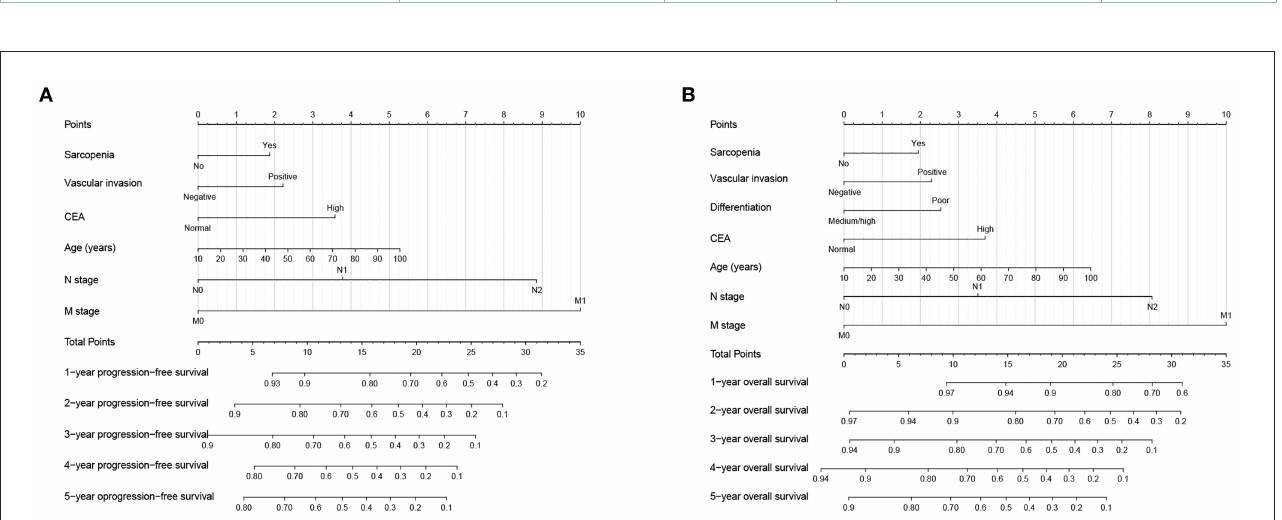
FIGURE3 Construction prognostic nomograms in CRC patients. (A) The Progression-free survival nomogram; (B) The overall survival